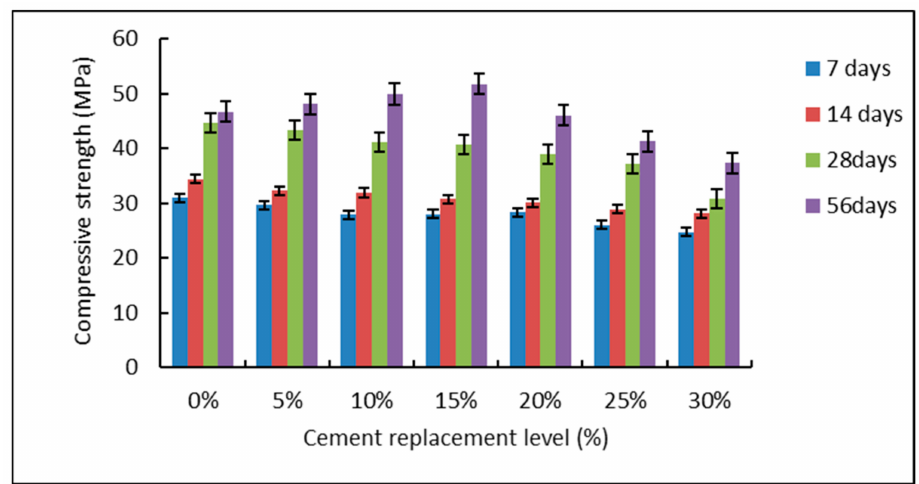
Figure 12. Compressive strength of blended BA